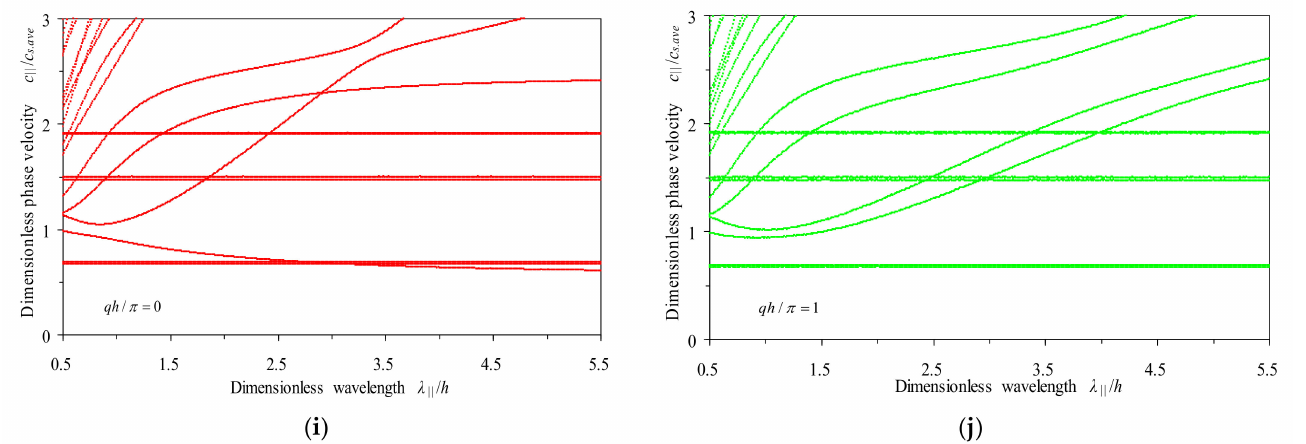
Figure 6. The comprehensive dispersion curves of Floquet in–plane waves propagating along the direction parallel to layering in the exemplified periodically octal–layered media. For qh / π = 0, they are ( a ) the frequency–wavenumber spectra, ( c ) the frequency–wavelength spectra, ( e ) the frequency– phase velocity spectra, ( g ) the wavenumber–phase velocity curves, and ( i ) the wavelength–phase ve- locity curves. For qh / π = 1, the corresponding dispersion curves are given in ( b , d , f , h , j ),